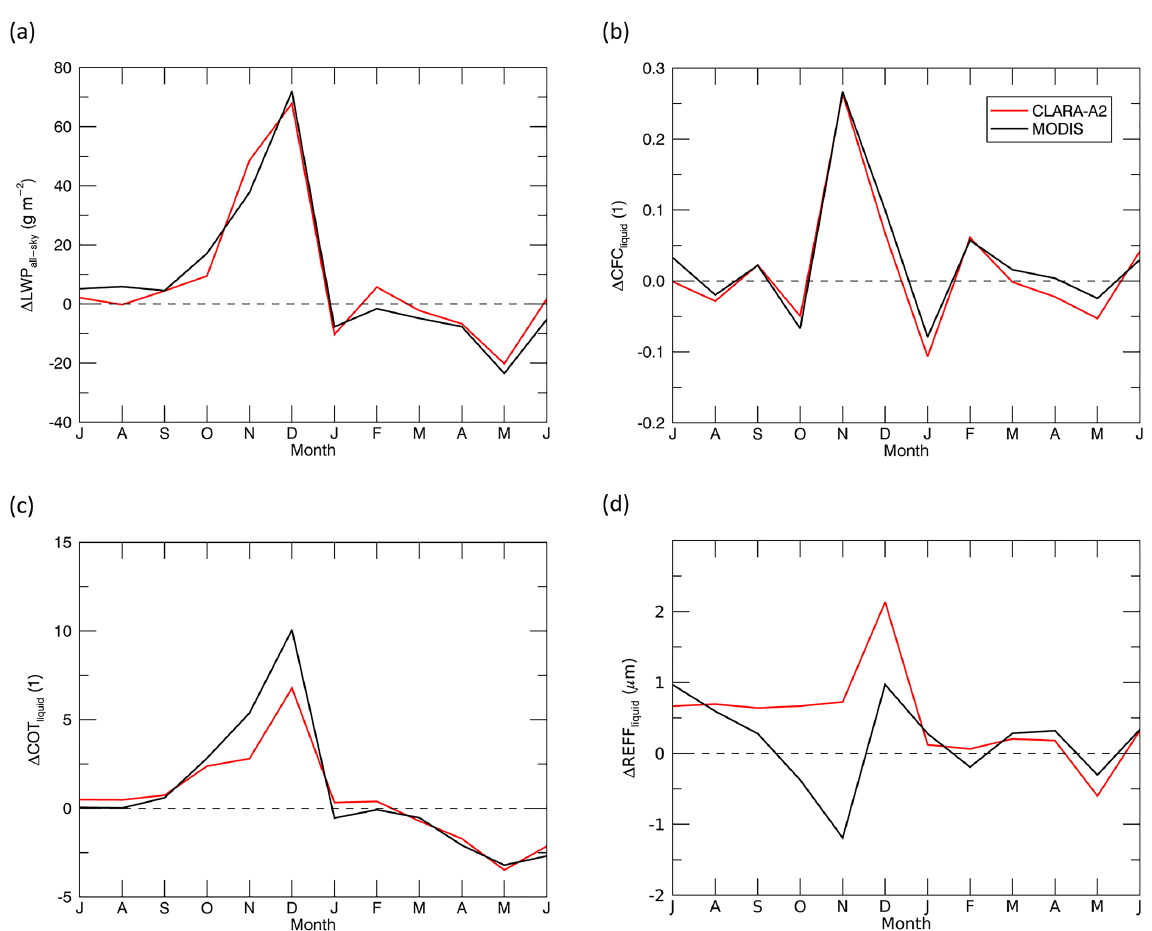
Figure 10. Seasonal variation of changes in liquid cloud properties over southern China. (a) All-sky LWP, (b) liquid CFC, (c) liquid COT and (d) liquid REFF changes from 2006 to 2015 based on CLARA-A2 and MODIS data.